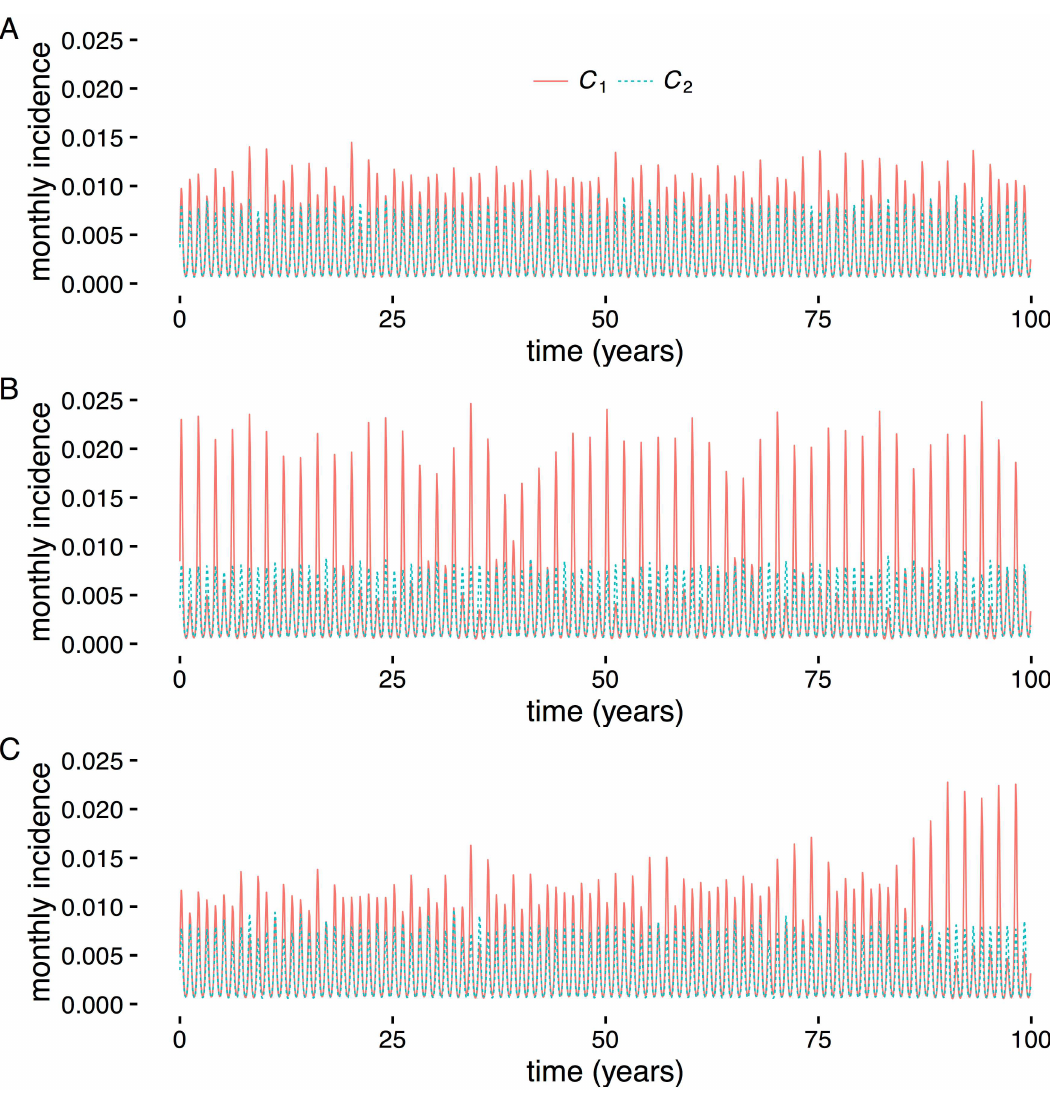
Fig 5. Incorrect inference with changing transmission rate. Exampletime series for testing transient dynamics. Each time series contained100 years of monthly incidencedata. The transmission rate β 1 for the driven strain C 1 was fixed at β 1 = 0.30 (A) and β 1 = 0.32 (B), and varied linearlyover time betweenthe two values (C). The transient time series yields high false positive and false negativerates under CCM. Interaction strength was σ 21 = 0.5, process noise was η = 0.01, and seasonalforcing was (cid:15) =